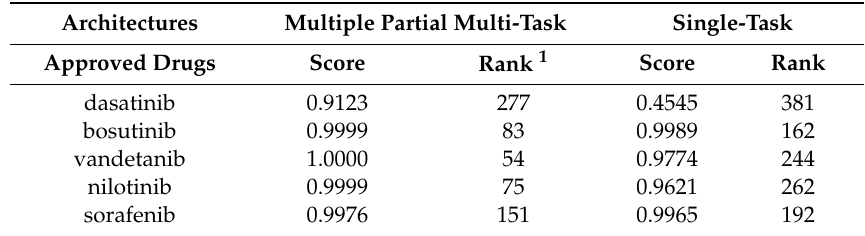
Table 7. Binding prediction of approved drugs of Tyrosine-protein kinase